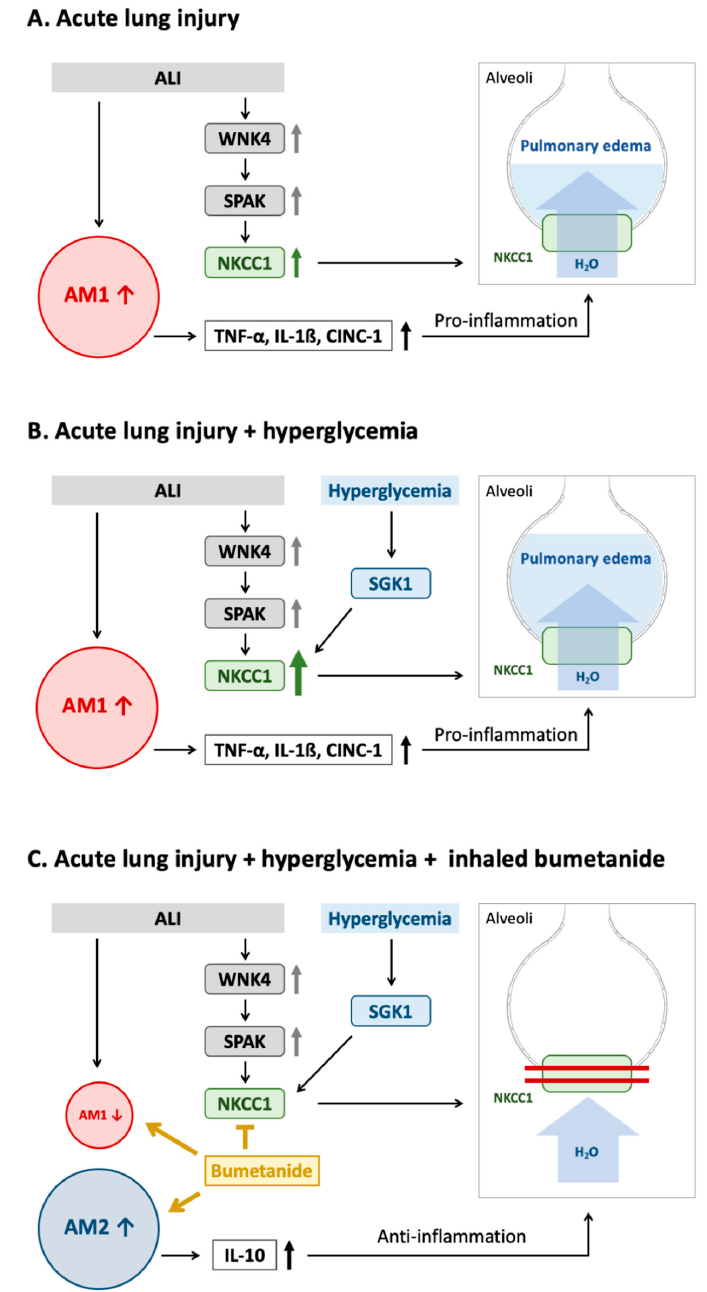
Figure 7. Mechanism underlying the effect of acute hyperglycemia on SGK1–NKCC1 pathway in